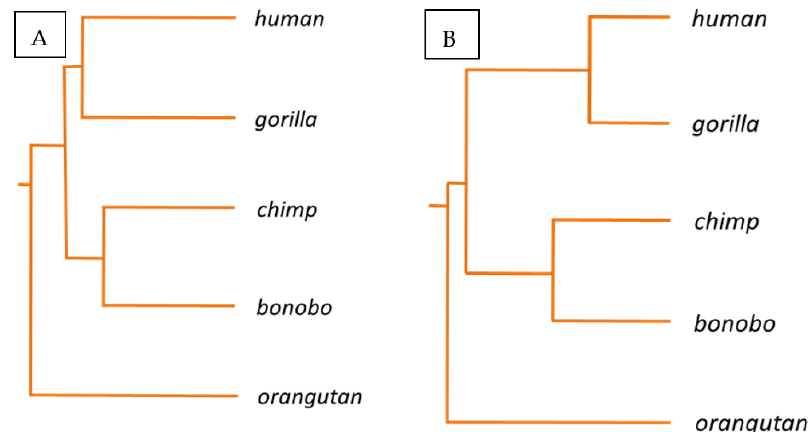
Figure 2. Phylogenetic ( A ) and “phylo-epigenetic” ( B ) relations between 5 primate species based on genetic and epigenetic differences of KIR gene promoter regions. The phylogram of the left panel displays the phylogenetic relation of these primate species, based on SNPs. The phylogram of the right panel displays the phylo-epigenetic relation of these species, based on CpG dinucleotide differences of the KIR gene promoter regions.